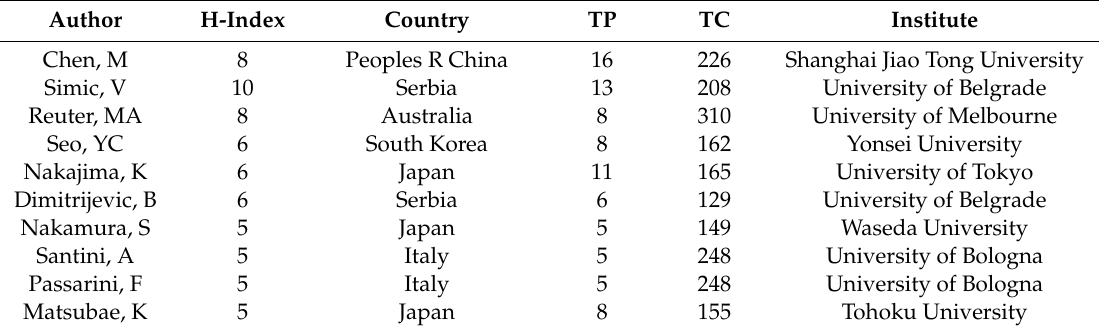
Table 4. Information on the 10 most influential researchers.